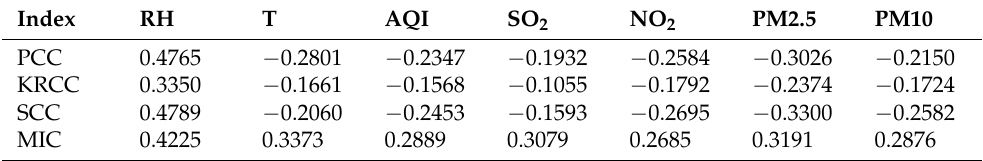
Table 3. Statistical correlations of atmospheric factors and corrosion rate in Stage 1.